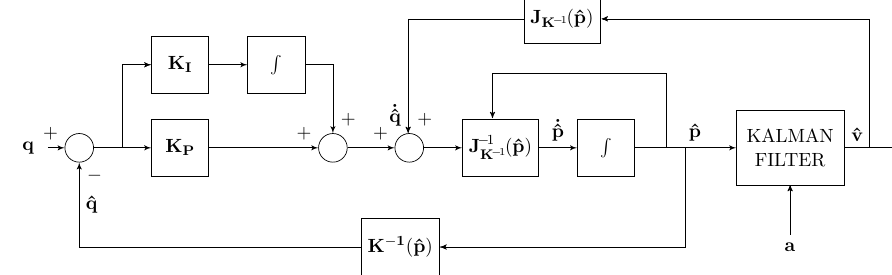
Figure 6. Test 4 estimator scheme with Kalman filter and velocity feedback.